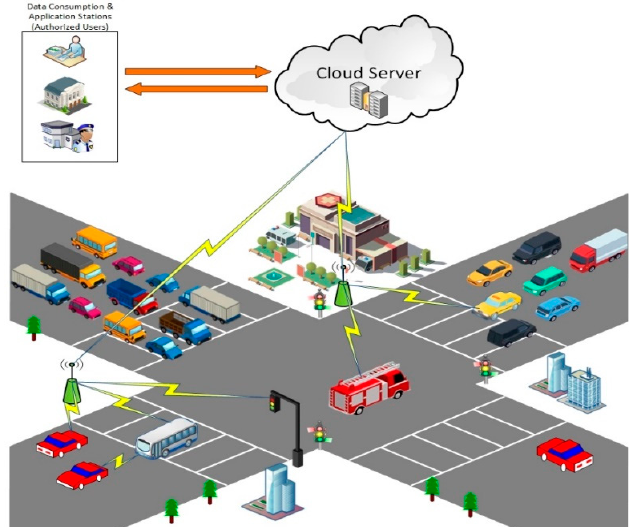
Figure 1. A typical scenario of IoV network.